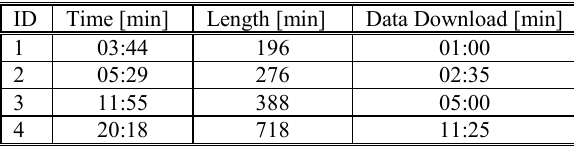
Table 2: Report of the acquisition step